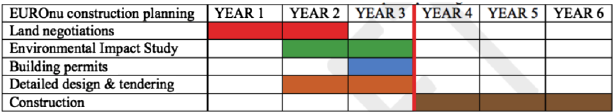
FIG. 50. Time line for the civil engineering of the beta beam